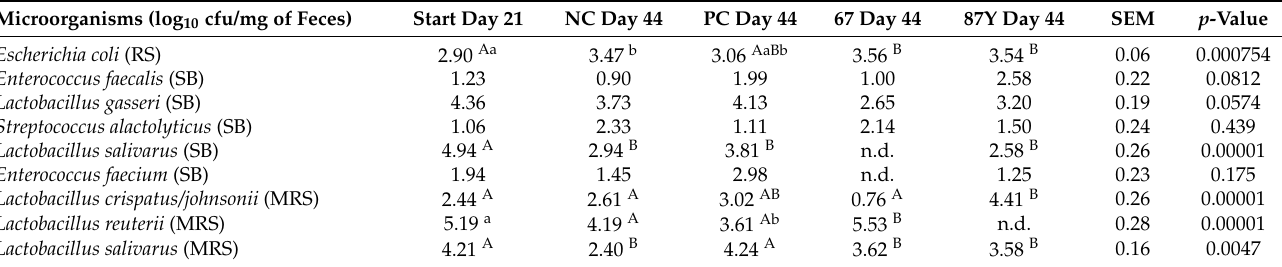
Table 4. Quantitative analysis of broiler cecal microbiome using chromogenic agar media. NC, negative control; PC, birds receiving 3% addition of URSM; 67, birds receiving 3% addition of FRSM by B. subtilis 67; 87Y, birds receiving 3% addition of FRSM by B. subtilis 87Y. Species names defined by MALDI-TOF-MS. RS, RAPID Salmonella agar; SB, StrepB select agar; MRS, MRS agar medium.